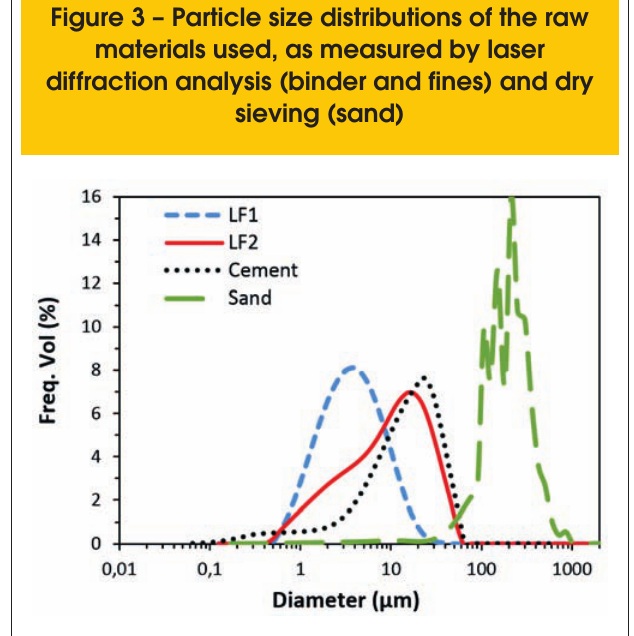
Figure 3 – Particle size distributions of the raw materials used, as measured by laser diffraction analysis (binder and fines) and dry sieving